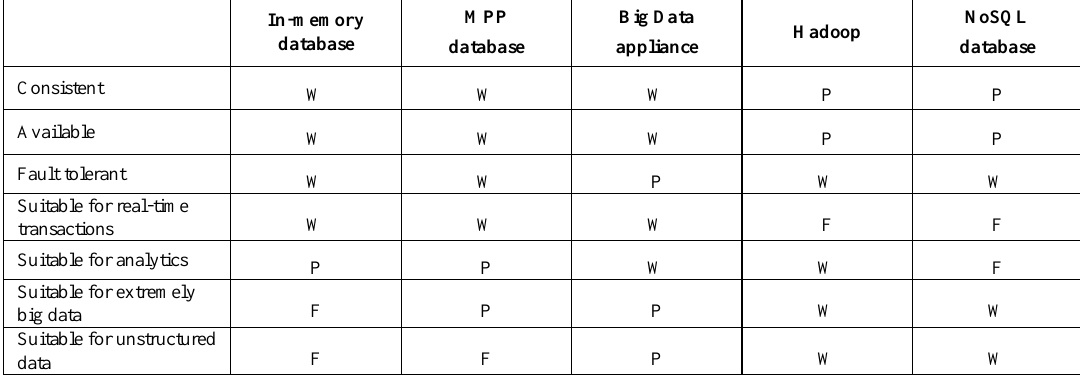
Table 3. Comparison of Big Data